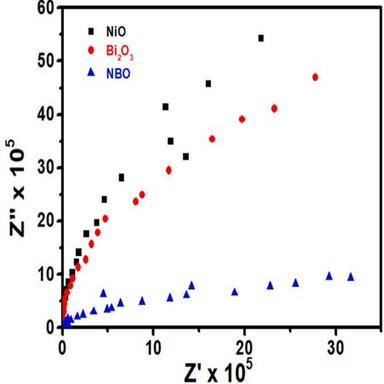
The photocurrent response of pure NiO, Bi2O3 and NBO composite photocatalysts.